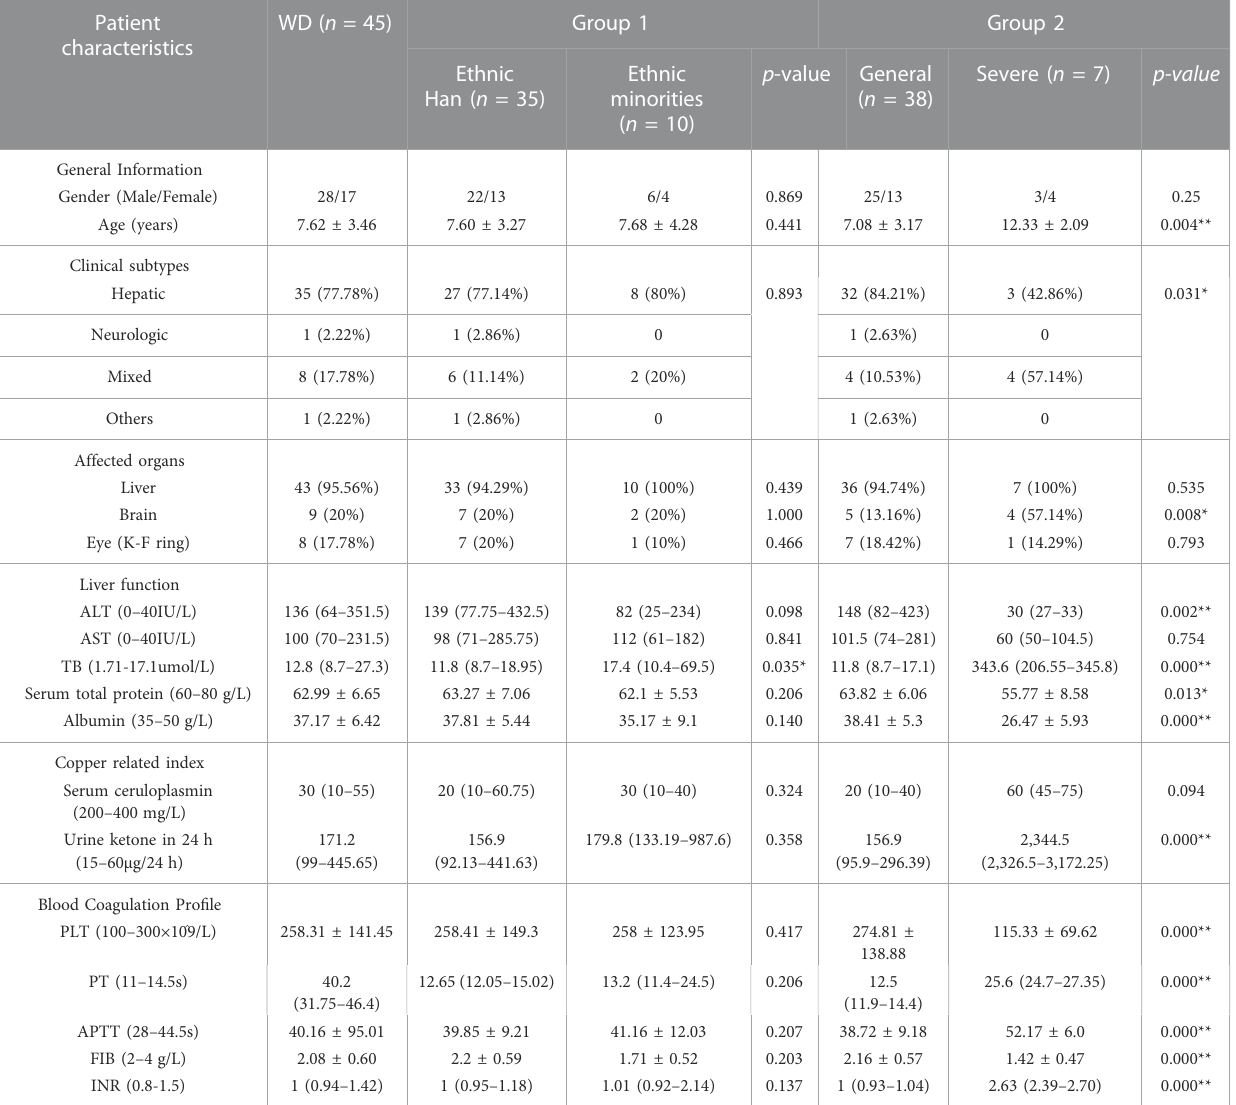
TABLE 1 Characteristics of 45 patients with Wilson ’ s disease clinical and laboratory